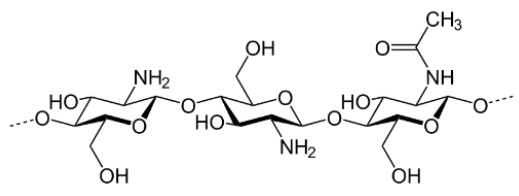
Figure 1 . Chemical structure of chitosan . Figure 1. Chemical structure of